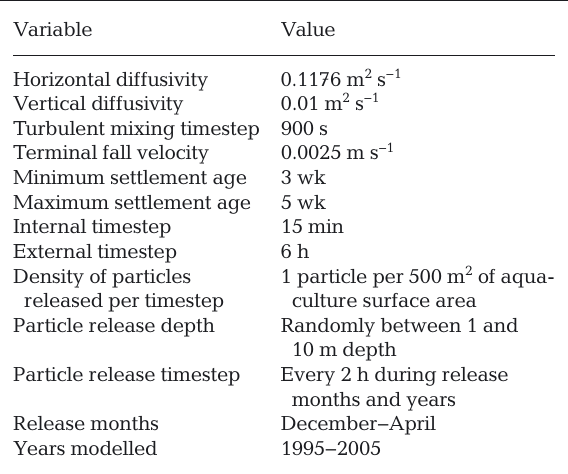
Table 1. Parameters used in biophysical modelling of Perna canaliculus in the Firth of